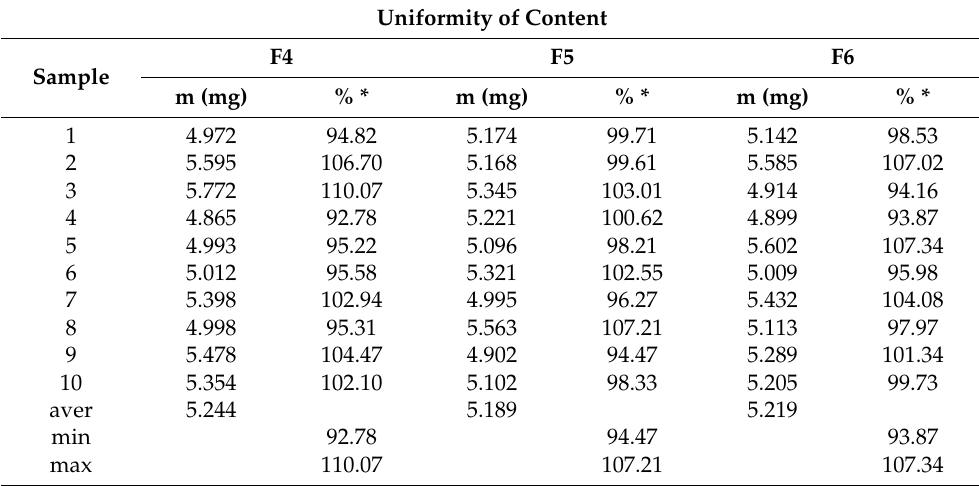
Table 5. Uniformity of pantoprazole content (mg/capsule) in three formulations (F4, F5, F6) after compounding.